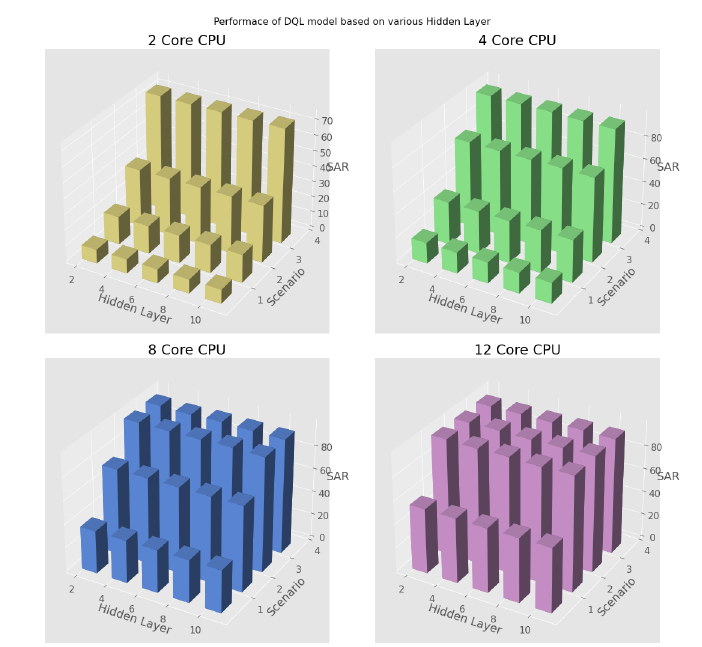
Figure 11. Hidden Layer performance in terms of